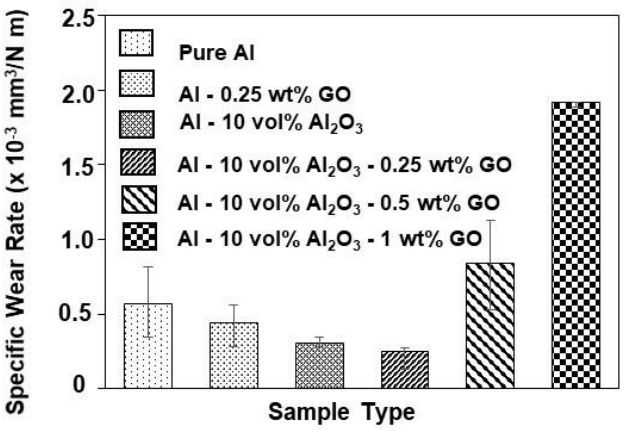
Figure 2. Variation of specific wear rate of different samples at a load of 3 N, sliding speed of 0.1 m/s, and a sliding distance of 100 m.